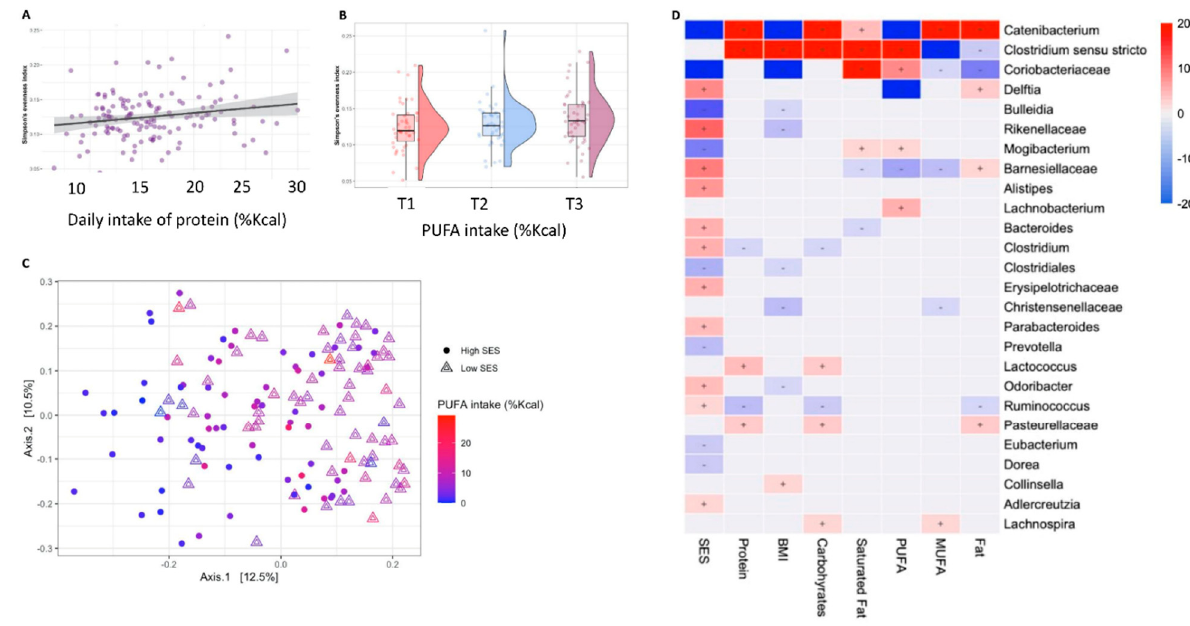
Figure 2. Bacterial diversity and composition. ( A ) A scatter plot of the correlation between alpha diversity, evaluated by Simpson’s evenness index, increased and intake of protein (%Kcal/day). ( B ) Box plot of alpha diversity, evaluated by Simpson’s evenness index according to tertiles consumption of PUFAs (%Kcal/day) (T1 = lowest tertile, T2 =middle tertile, T3 = upper tertile). ( C ) Principal component analysis (PcoA) of the Unweighted UniFrac distance showing a significant separation based on the SES score and intake of PUFAs. ( D ) A heatmap of the multivariable model describing the top 50 associations between the independent variables and bacterial features. Positive associations are colored in red, while inverse associations are colored in blue. The color gradient represents the strength of the association (the effect size), with darker colors representing the stronger associations. The effect size was calculated by the following formula: ( − log(qval)*SIGN